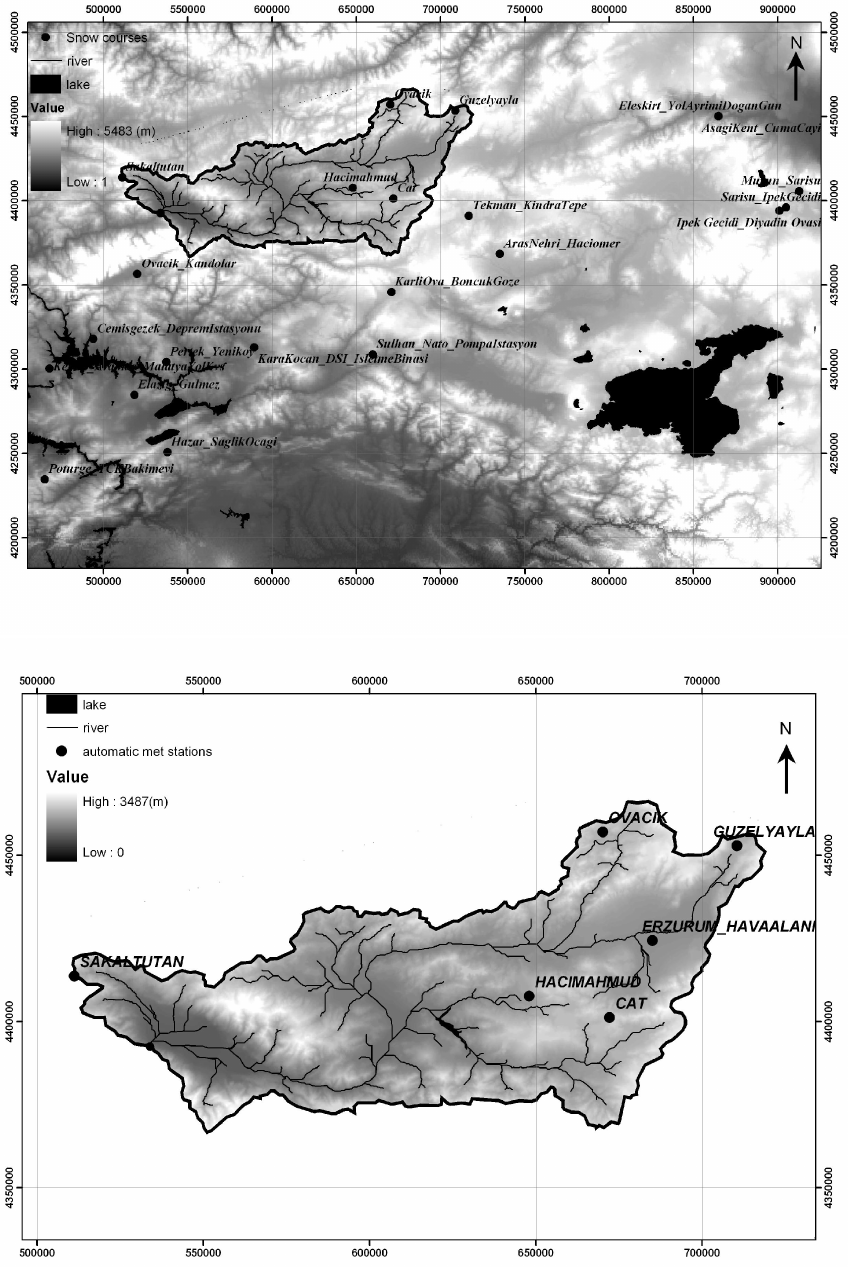
Fig. 2. (a) Snow courses on the topograpic map of Karasu Basin and the surrounding area, (b) AWOS locations on the DEM of Karasu Basin.